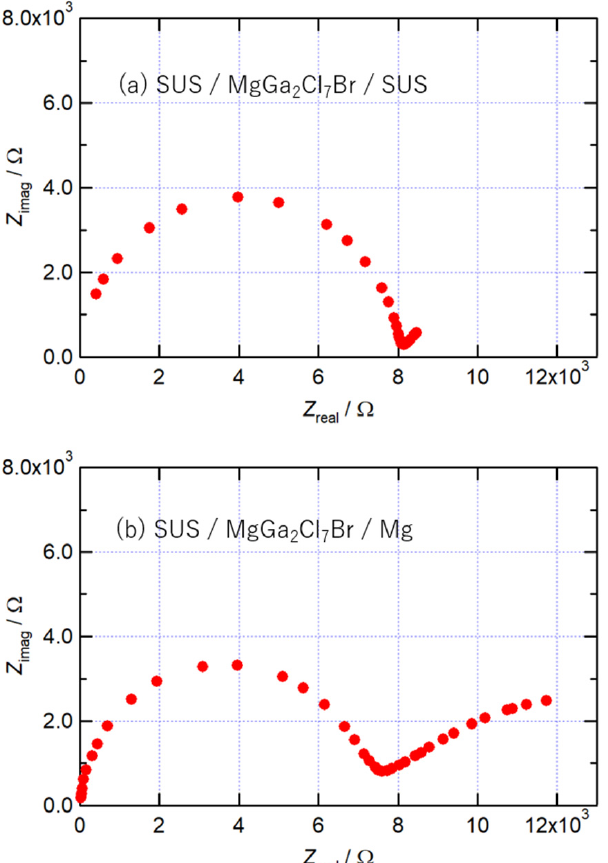
Figure 4. Nyquist plots of MgGa 2 Cl 7 Br at 400 K obtained using ( a ) stainless and ( b ) Mg as a working electrode.